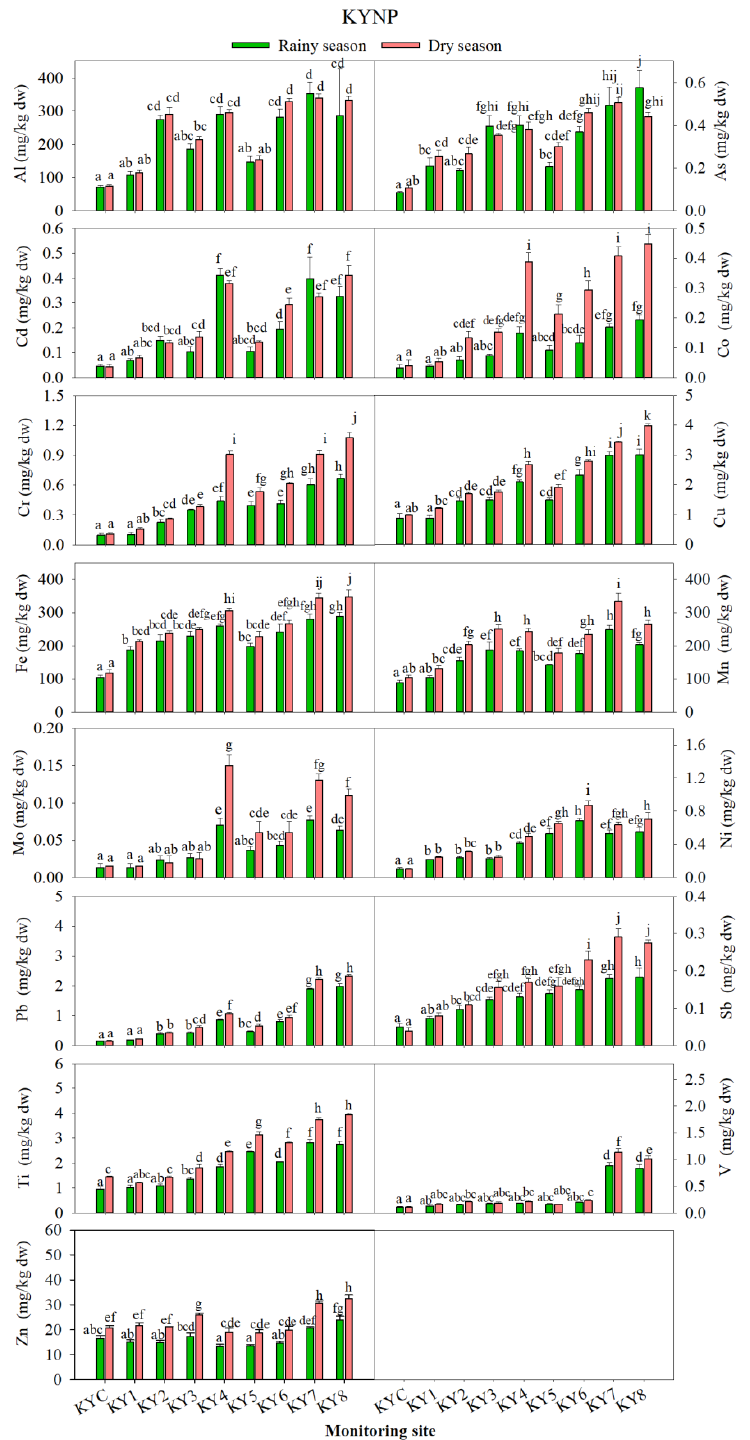
Figure 4. Average concentration of each potentially toxic element (PTE, n = 3) at each site during the rainy and dry seasons in Khao Yai National Park (KYNP). The different letters on a graph of each PTE indicates statistically significant difference by one-way ANOVA with Tukey test, p < 0.05, n = 3.